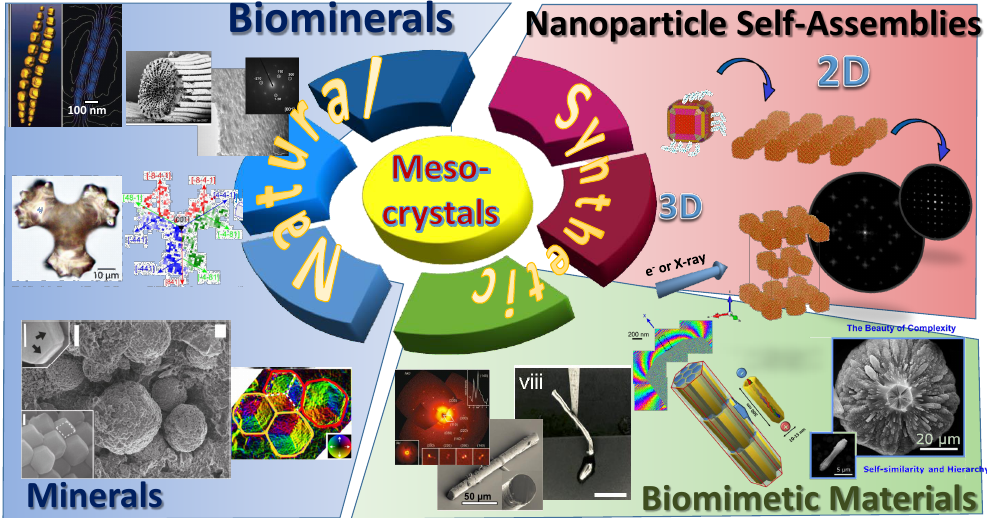
Figure 3. Schematic illustration of mesocrystals in biominerals, abiogenic minerals,